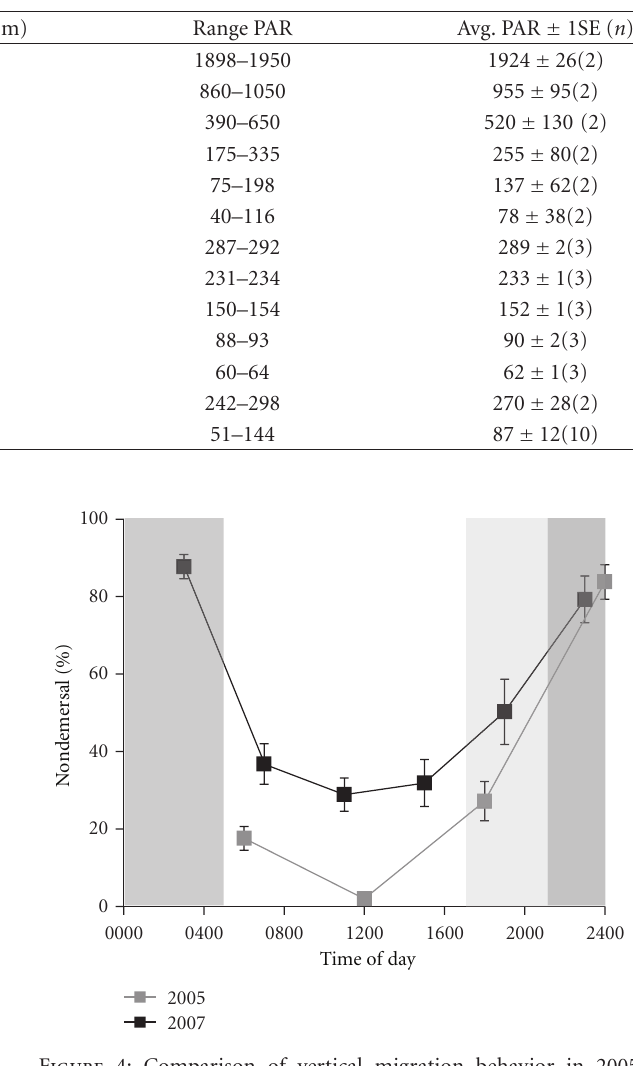
Figure 4: Comparison of vertical migration behavior in 2005 trials versus 2007 trials using larvae of similar ages showing the percentage of nondemersal larvae as a function of time of day. Data collected in 2007 were reanalyzed by converting to % nondemersal in order to make the datasets comparable. Shading indicates timing of light cycles. Light grey shading indicates darkness in 2005. Dark grey shading indicates darkness for both years. Error bars represent ±